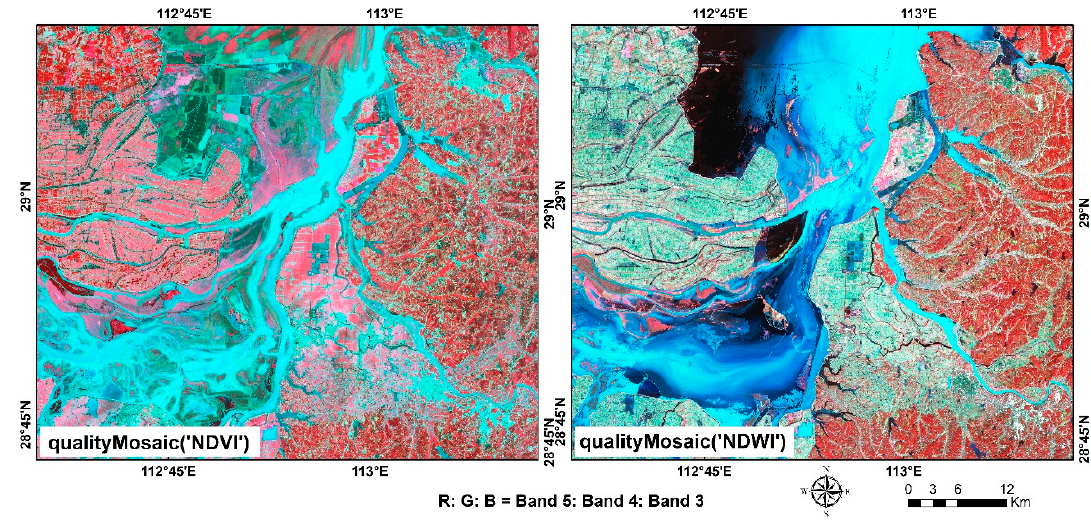
Figure 5. The greenest and wettest images in the Dongting Lake Section (DtLS) sub-basin in 2017.